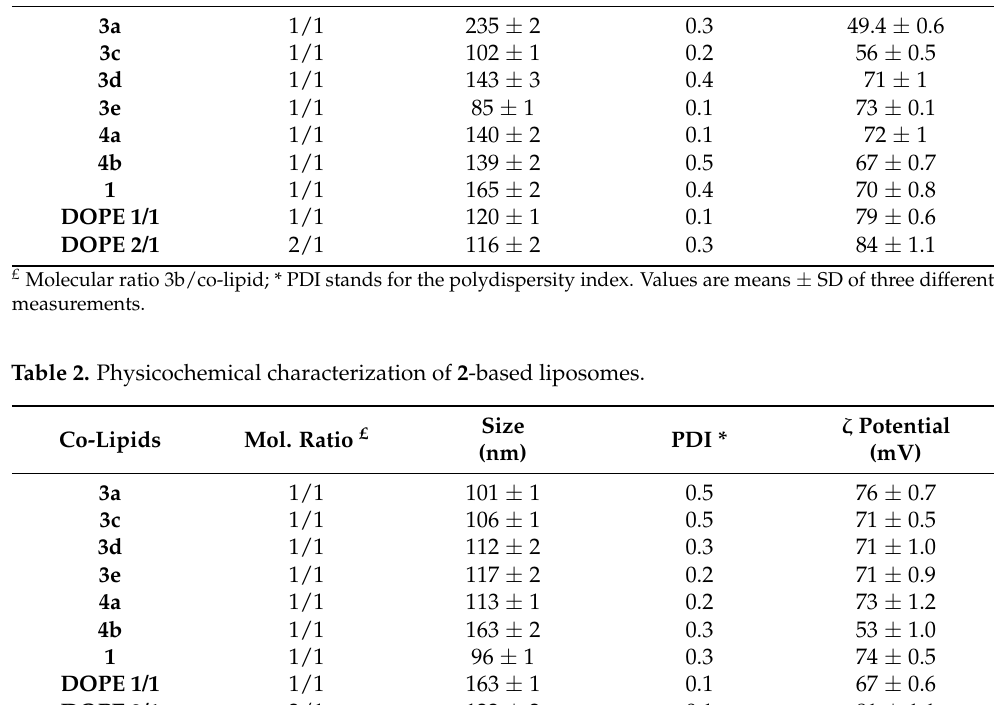
For the series 3b , the most fusogenic liposomes at acidic pH were those including co-lipids 3a or 1 (Table 3). The presence of an imidazole group close to the phosphonate of the co-lipid is not a determining factor when associated with lipid 3b . Other 3b -liposomes with co-lipids 3c or 4a featured an intermediate fusogenic behaviour. Finally, 3b -liposomes associated with co-lipids 3d , 3e , 4b or DOPE were not or only weakly fusogenic. Of note, the presence of a terminal pyridine as polar head group ( 3d and 4b ) did not promote membrane fusion both at neutral and acidic pH. Overall, the presence of an imidazole in the head group of co-lipids of α -amino-lipophosphonates featuring two ionizable aza- heterocycles (imidazole, 3a or pyridine, 4a ) induced membrane fusion at pH 5.5. Liposomes of the series 2 were not or weakly fusogenic at neutral pH. Only liposomes with co-lipids 1 or DOPE were highly fusogenic at pH 5.5 which is the pH of the lumen of late endosomes. To sum-up, the presence of an imidazole group close to the phosphonate did not promote membrane fusion when associated with lipid 2 . Moreover, the association of DOPE with lipid 2 and 3b at a lipid molar ratio of 1/1 and 2/1 increased the fusogenicity of liposomes at pH